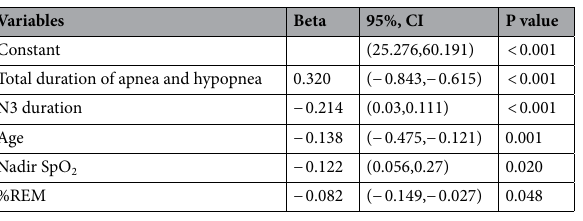
Table 5. Model for the prediction of change in slow wave sleep. CI confidence interval, SpO 2 pulse oxygen saturation, REM% percentages of rapid eye movement